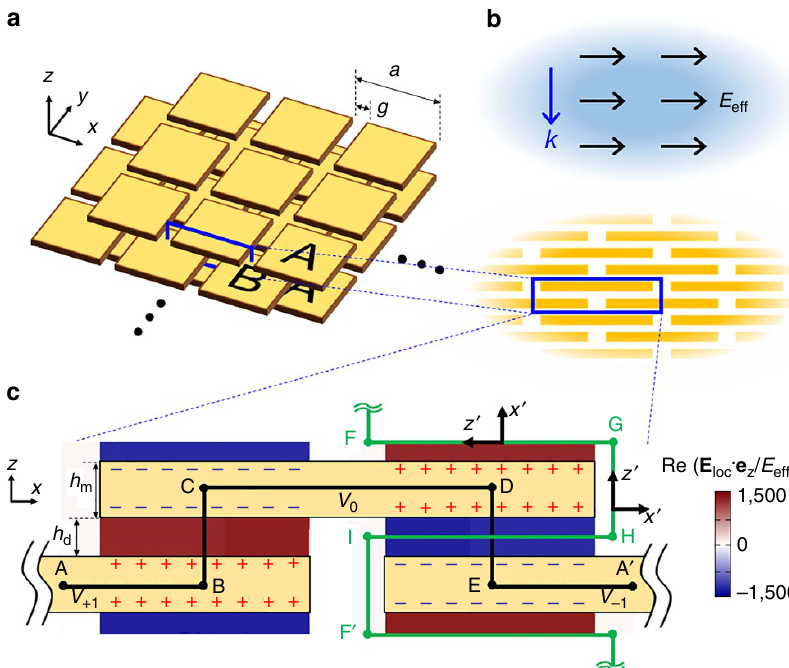
Figure 1 | A giant refractive index mesoscopic crystal. ( a ) A schematic of the proposed mesoscopic crystal. Electrically insulated metal plate layers are stacked in A-I-B-I fashion with half-unit cell shifts of metal layers where ‘I’ layers indicate insulating layers. The insulating dielectric host is not shown for clarity and fills the entire space between metals. ( b ) The mesoscopic structure (lower figure) can be homogenized to effective medium (upper figure). The blue rectangle indicates a single unit cell cross section. ( c ) The z directional local electric field profile in a single unit-cell cross section was obtained from an x – z 2-dimensional numerical simulation assuming copper in silica host (Methods). Similar profile of local electric field in x direction is in Supplementary Fig. 3. The green solid line indicates the space filling curve. The structural dimensions used for the simulation were a ¼ 750 m m, g ¼ 100 m m, h m ¼ 400nm, and h d ¼